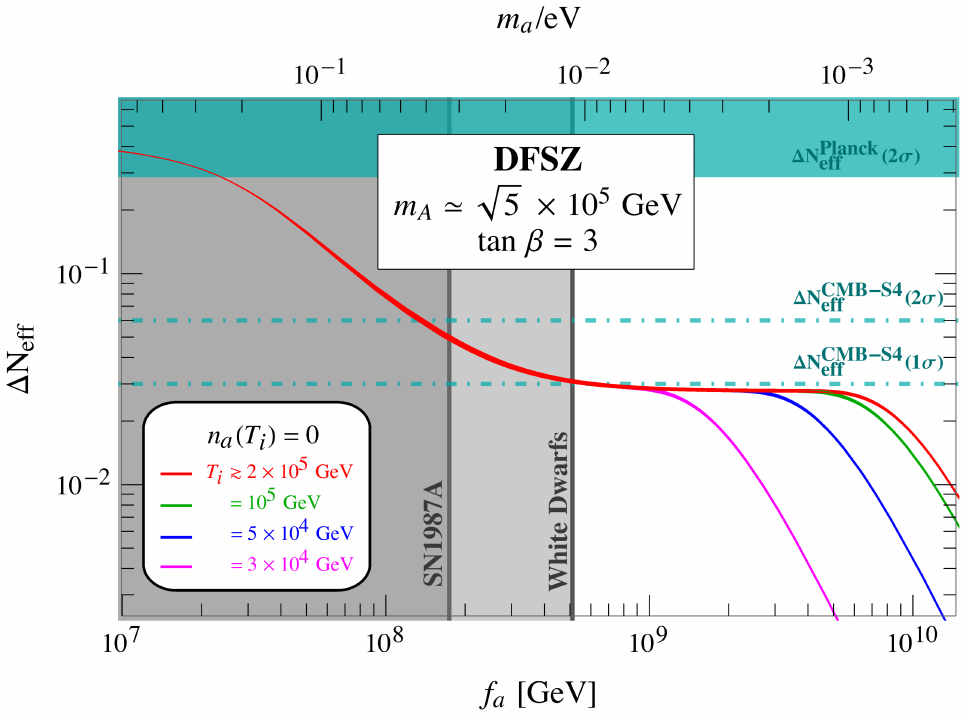
Figure 12 . Same as figure 11 but for tan β = 3